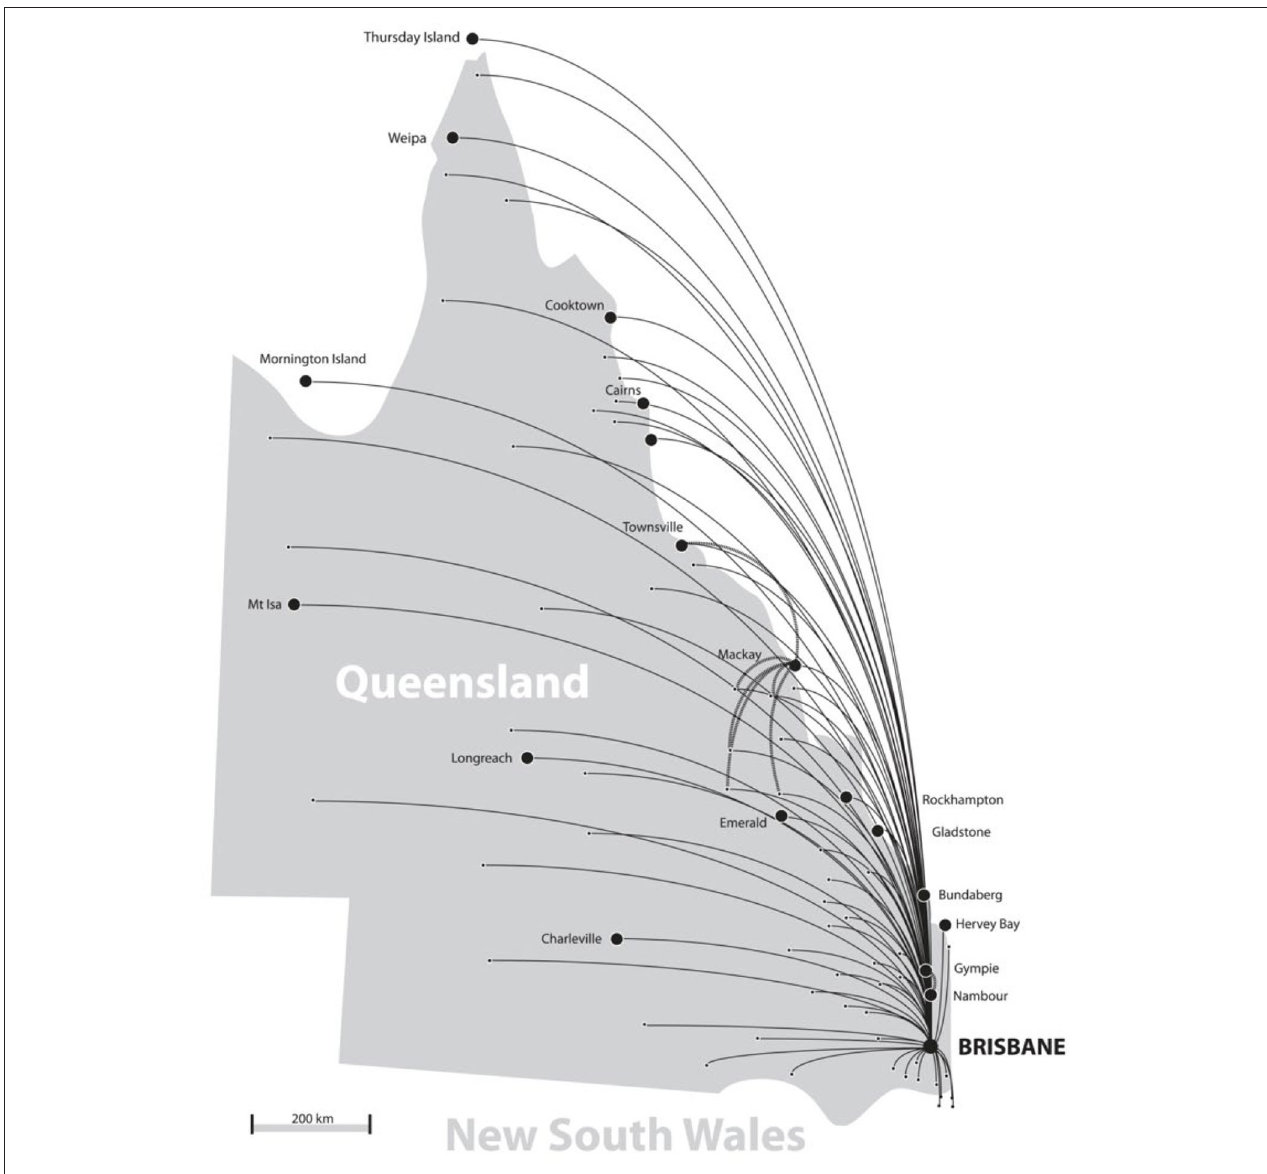
FIGURE 2 | QTS main referral sites in Queensland and New South